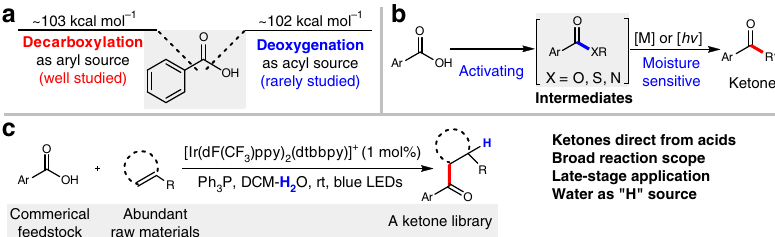
Fig. 1 Applications of aromatic carboxylic acids in organic synthesis. a The nature choice of aromatic carboxylic acid. b Known ketone synthesis from acids (indirect strategies). c This work: direct deoxygenative C – C coupling by visible